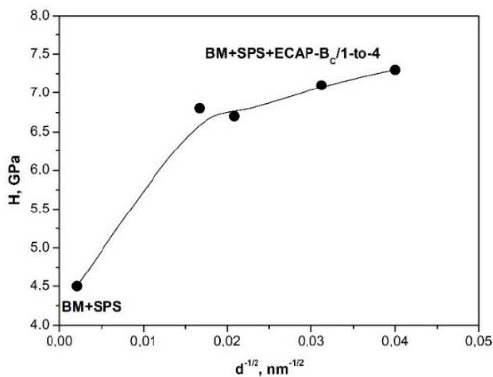
Figure 5. Hardness, H , vs. mean grain size, d –1/2 , for BM + SPS (bottom-up process) and BM + SPS + ECAP-B C /1–4 (top-down process).